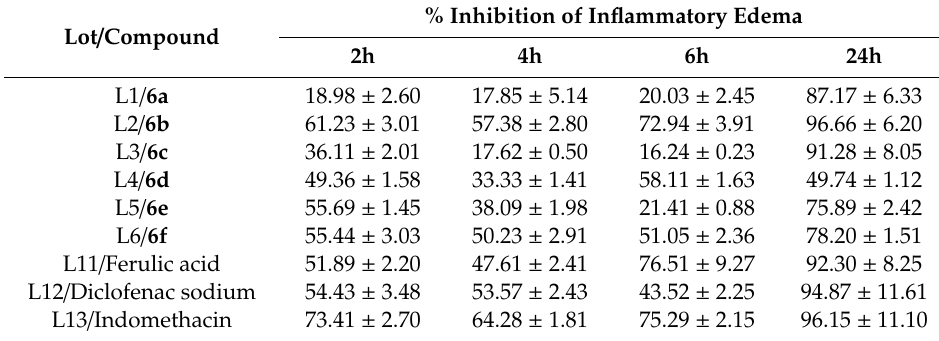
Table 3. Anti-inflammatory e ff ect (% inhibition of inflammatory edema) of the tested compounds ( 6a–f ) compared to ferulic acid, diclofenac sodium, and indomethacin at di ff erent time intervals. % Inhibition of Inflammatory Edema Lot / Compound